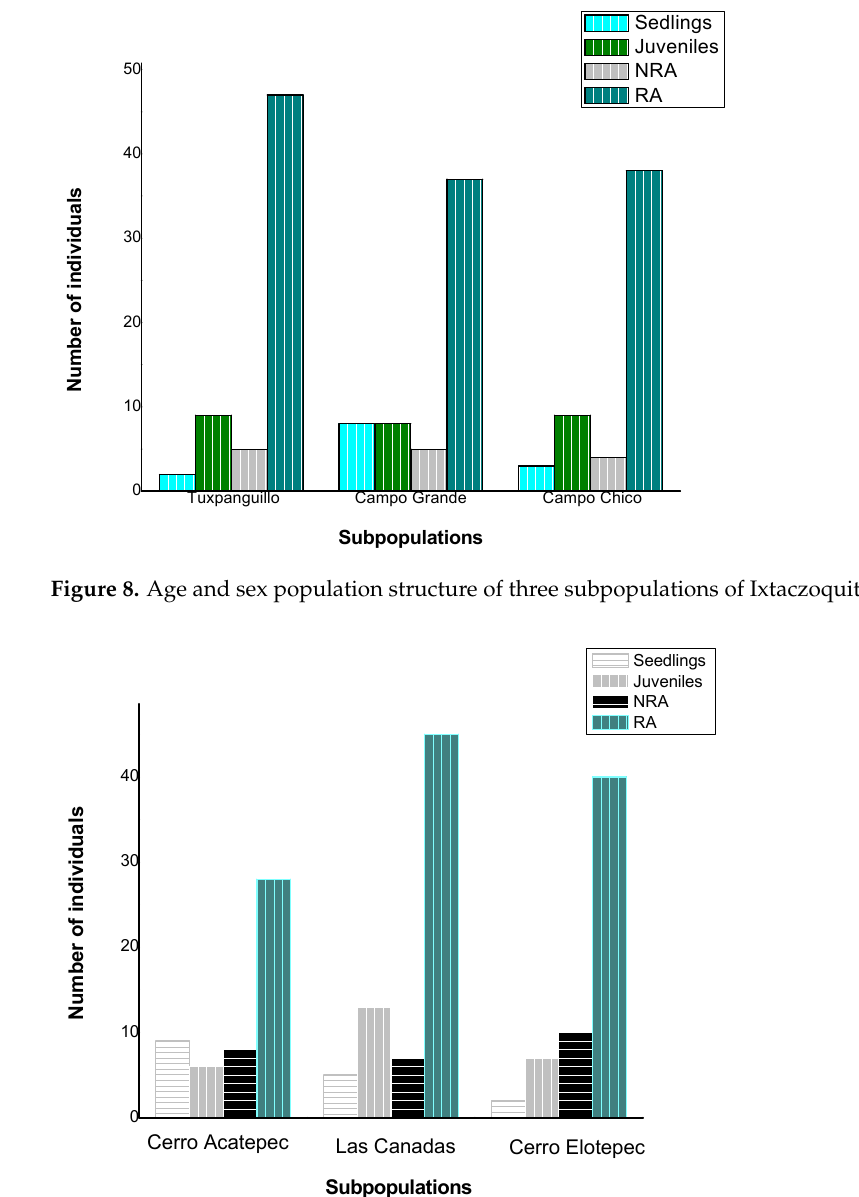
Figure 9. Age and sex population structure in three subpopulations of Huatusco.